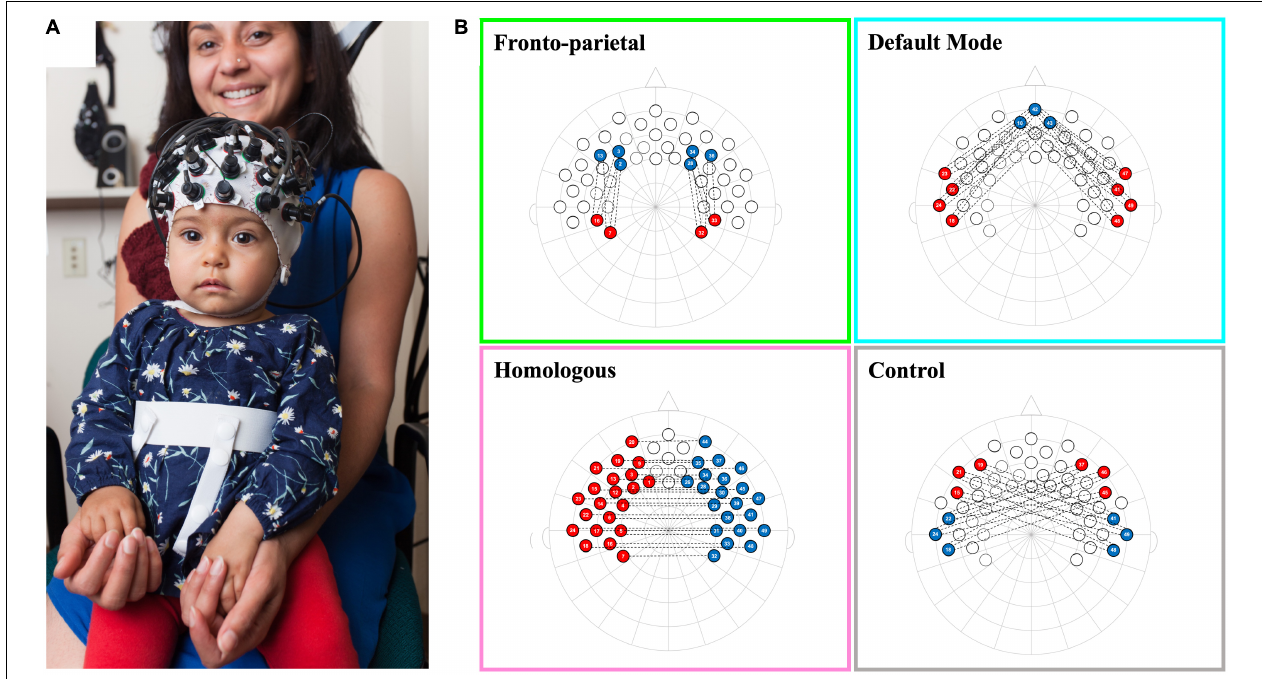
FIGURE 1 | Schematic of infant network configurations measured using fNIRS. Panel (A) shows a infant wearing a functional near-infrared spectroscopy (fNIRS) cap with our 10–20 system optode array. Panel (B) shows the configurations for each of the network patterns in a 2-dimentional 10–20 system layout. Each network consists of the average of the correlations between each red-blue channel pair that is connected by a dotted line.